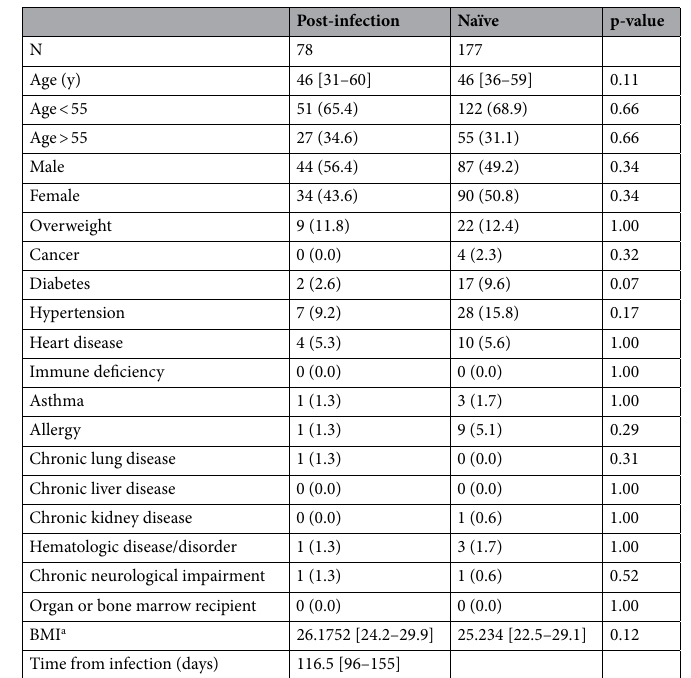
Table 1. Baseline characteristics. Data are presented as n (%); continuous data, median [IQR]. a The body- mass index is the weight in kilograms divided by the square of the height in